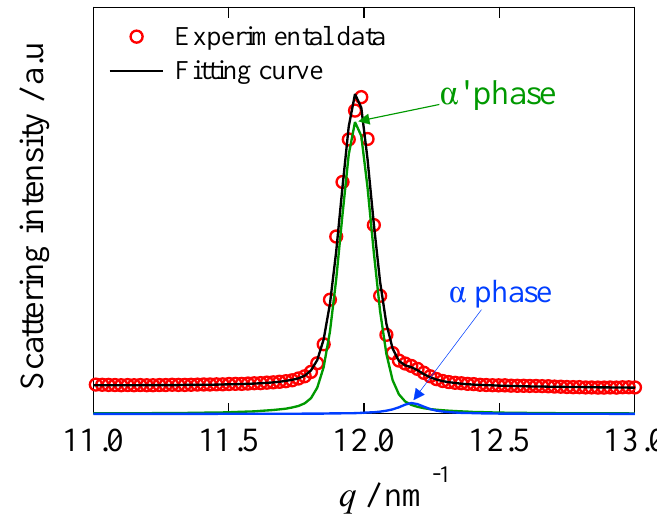
Figure 3. Decomposition of the (200)/(110) reflection peak in the range of 11 < q < 13 nm − 1 .